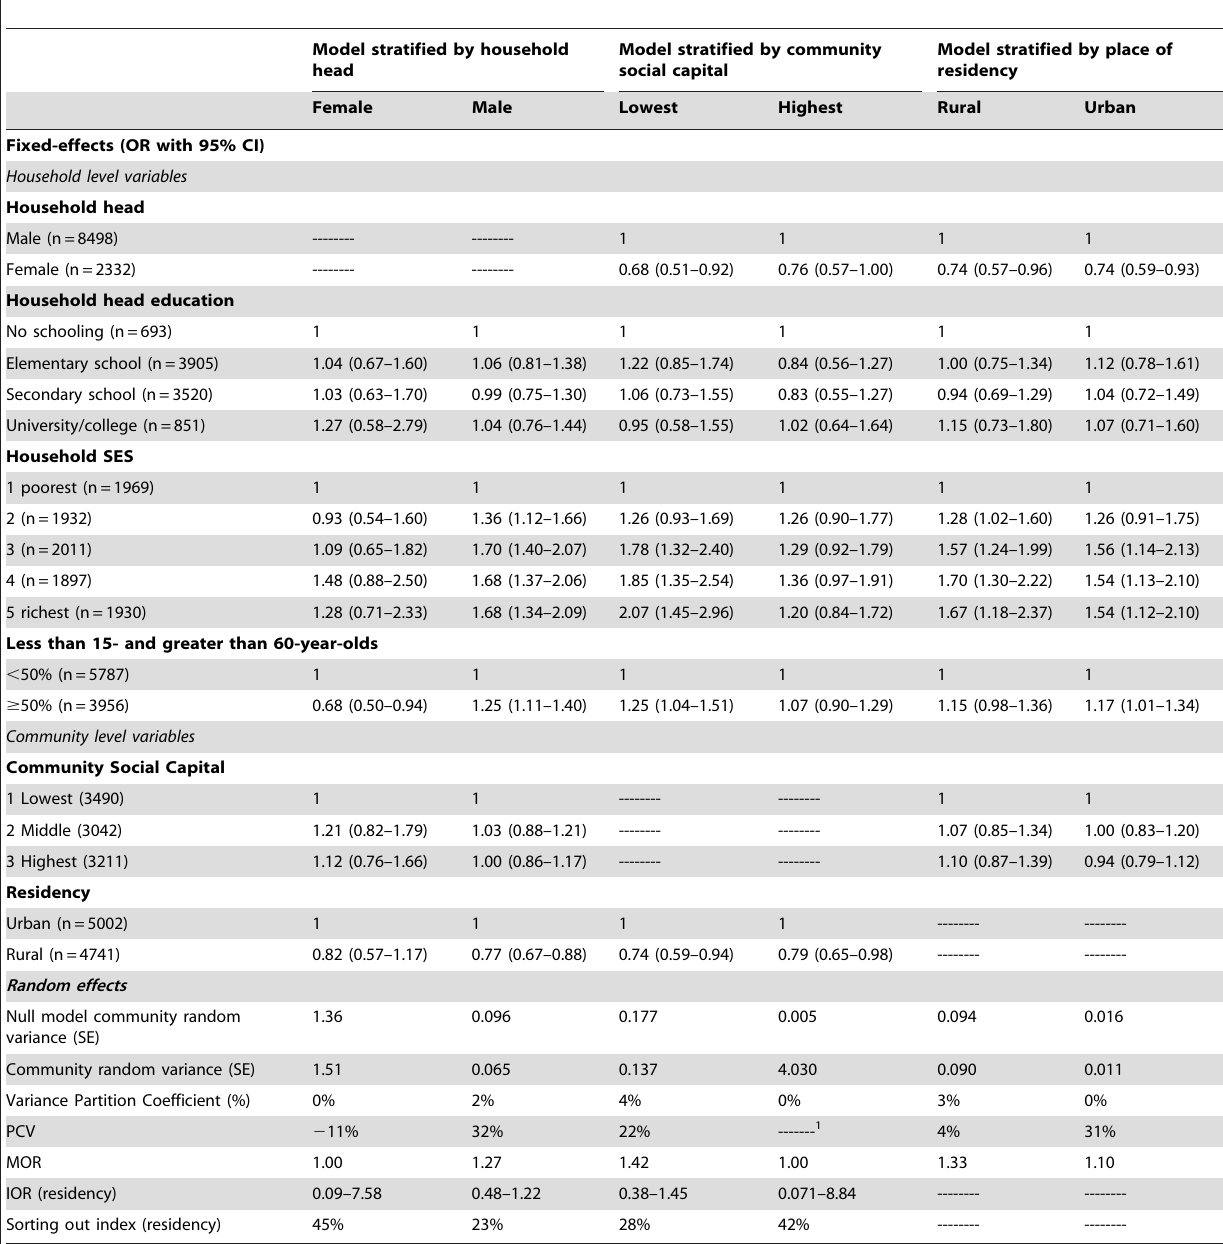
Table 3. Household and community level characteristics associated with dual burden of malnutrition in Indonesia in 2007 across households with different